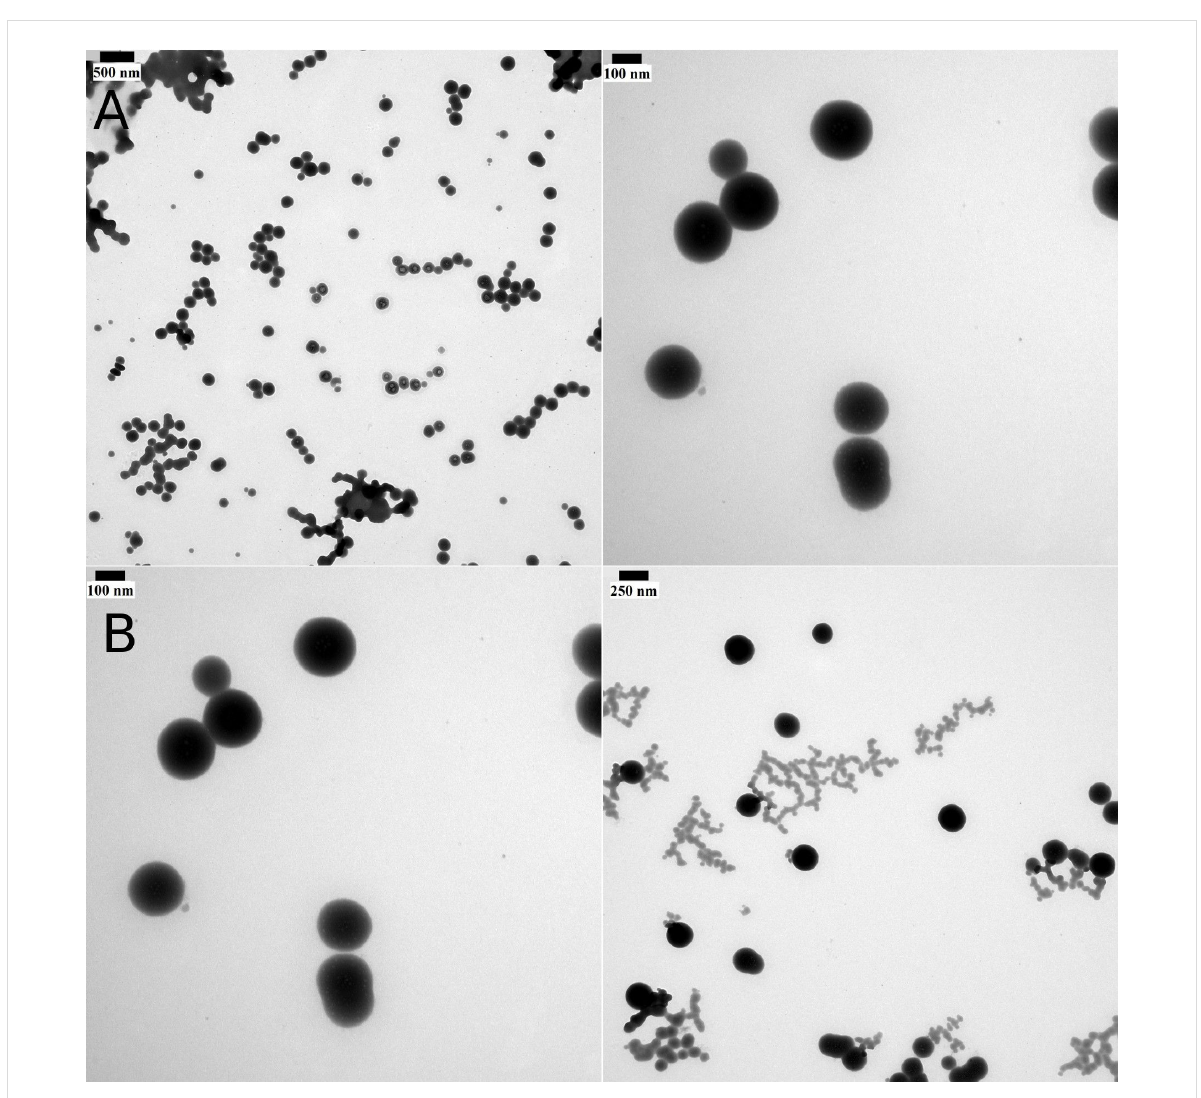
Figure 4: TEM images for the nanoparticles based on 3 . The nanoparticles were obtained by dispersing the click reaction product ( 3 ) in water. with a concentration of 1% (A) and 2% (B).